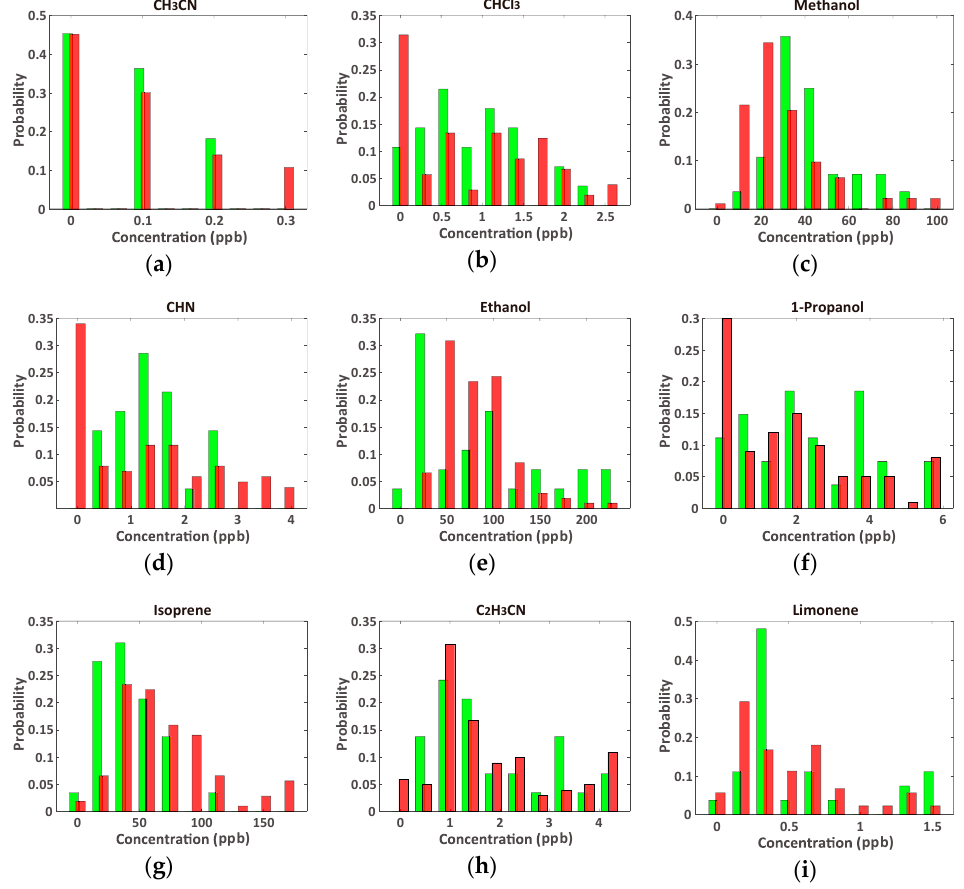
Figure 2. Comparison of VOC concentration distributions from lung cancer (red, n = 107) and healthy (green, n = 29) controls’ breath; ( a ) CH 3 CN; ( b ) CHCl 3 ; ( c ) methanol; ( d ) CHN; ( e ) ethanol; ( f ) 1-propanol; ( g ) isoprene; ( h ) C 2 H 3 CN; and ( i ) limonene. The VOCs in ( a – e ) show significant differences between samples, while those in ( f – i ) do not show significant differences (Table 1). The distributions of the remaining 11 VOCs are shown in the Supplementary Information (Figure S1).